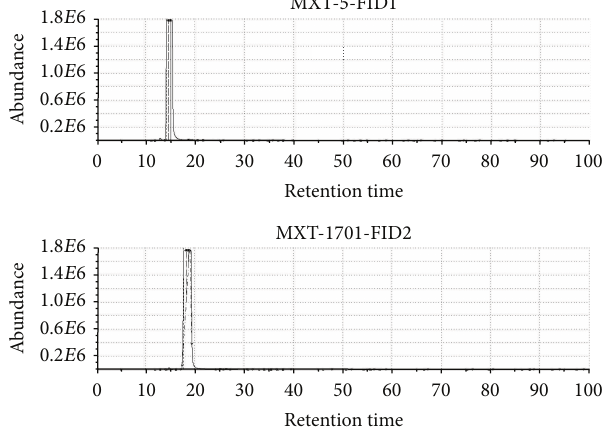
Figure 11: An example of a vodka sample presented in a chro- matogram.